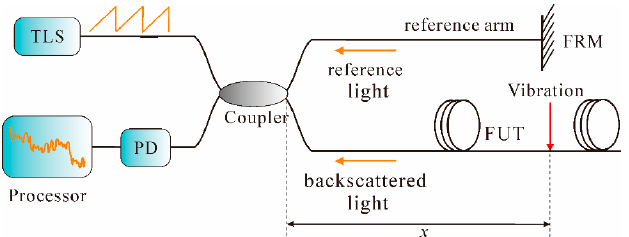
Figure 14. Basic arrangement of OFDR system.